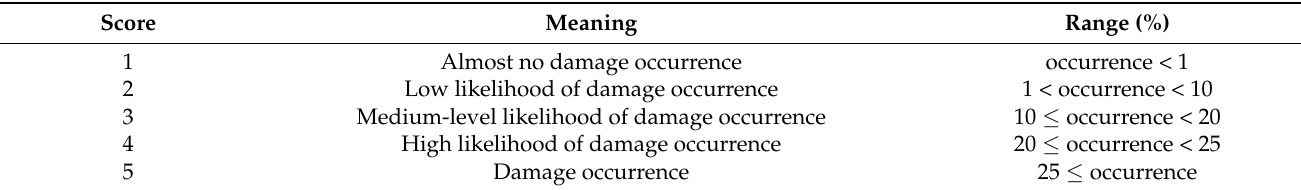
Table 5. Occurrence (P) score estimation criteria.